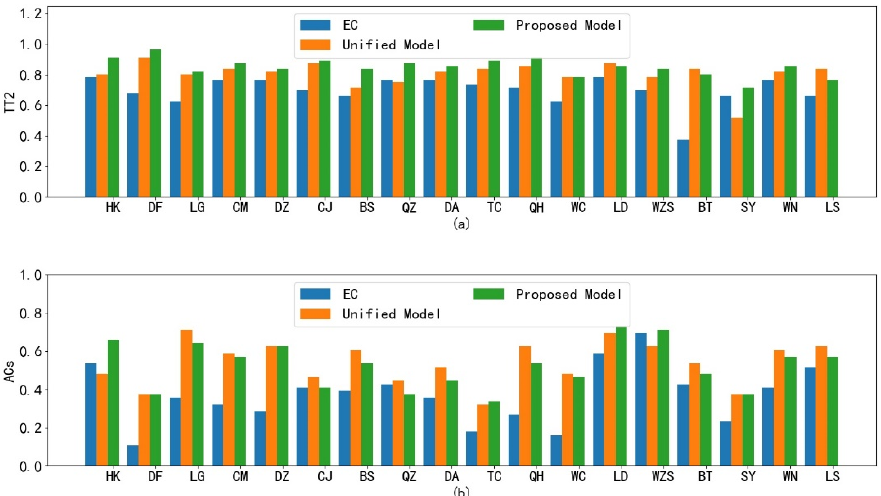
Figure 10. Comparison between the proposed spatial lightGBM and unified spatial lightGBM in terms of their temperature and wind forecasts: ( a ) 𝑇𝑇 (cid:2870) index comparison; ( b ) 𝐴𝐶 (cid:3046) index